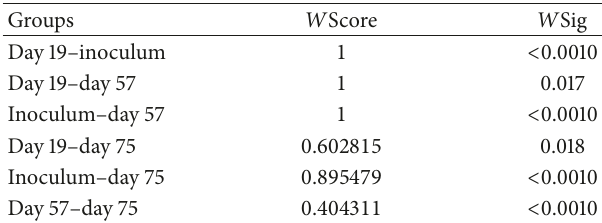
Table 1: Calculation of significance of 16S rRNA samples separation at different time points of anaerobic